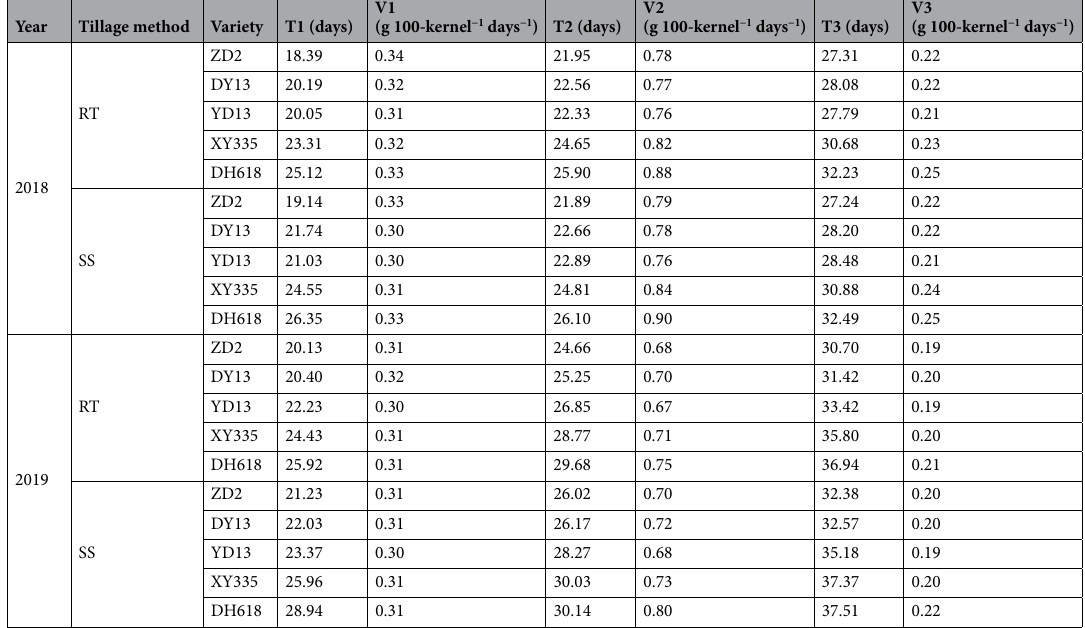
Table 5. Response of the grain filling rate parameters of maize varieties from different eras to tillage methods. T1 represents the grain filling duration of the gradually increasing stage, V1 represents the average grain filling rate of the gradually increasing stage, T2 represents the grain filling duration of the rapidly increasing stage, V2 represents the average grain filling rate of the rapidly increasing stage, T3 represents the grain filling duration of the slowly increasing stage, and V3 represents the average grain filling rate of the slowly increasing stage.